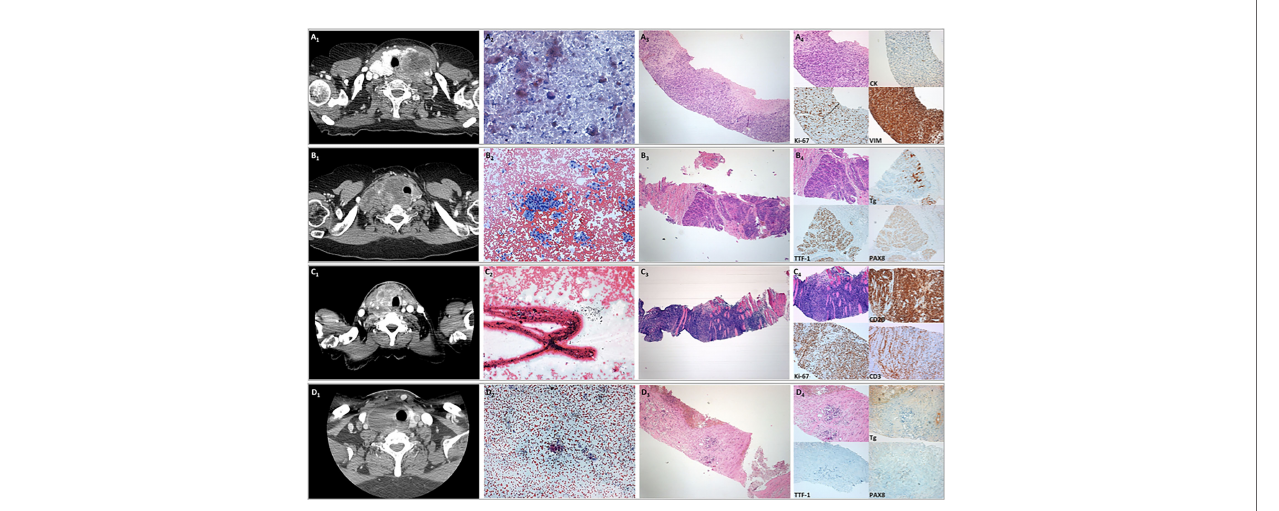
FIGURE 1 | Correlation of the results of CT scan with those of fi ne needle aspiration cytology (FNAC), core needle biopsy (CNB), and speci fi c immunohistochemical staining for anaplastic thyroid carcinoma (ATC), poorly differentiated thyroid cancer (PDTC), thyroid lymphoma (TL), and thyroid gland metastases (TGM) of lung adenocarcinoma. (A) Representative cytological and histological images of a case of ATC. ( A1 ) CT scan with i.v contrast imaging. ( A2 ) FNAC sample showing a few isolated atypical cells in a necrotic background (original magni fi cation, ×40; Papanicolaou staining). ( A3 ) CNB provided a tissue fragment composed of malignant undifferentiated neoplasia (original magni fi cations, ×4 and ×10; H&E staining). ( A4 ) Immunohistochemical staining showing neoplastic cells with a high proliferative index, immunoreactivity for vimentin, and patchy weak immunopositivity for cytokeratins. (B) Representative cytological and histological images of a case of poorly differentiated thyroid carcinoma. ( B1 ) CT scan with i.v contrast imaging. ( B2 ) FNAC sample showing numerous groups of follicular cells with moderate nuclear atypia (original magni fi cation, ×10; Papanicolaou staining). ( B3 ) CNB showing neoplastic cells arranged in solid and trabecular architecture (original magni fi cations, ×4 and ×10; H&E staining). ( B4 ) Immunohistochemical staining showing focal weak immunoreactivity for thyroglobulin and diffuse immunoreactivity for TTF-1 and PAX8. (C) Representative cytological and histological images of a case of TL. ( C1 ) CT scan with i.v. contrast imaging. ( C2 ) FNAC sample not diagnostic for the presence of extensive crush artifacts (original magni fi cation, ×20; Papanicolaou staining). ( C3 ) CNB provided a fragment of tissue composed of muscular tissue with intense lymphoid in fi ltration (original magni fi cations, ×4 and ×10; H&E staining). ( C4 ) Immunohistochemical staining showing that neoplastic cells were CD20 positive and CD3 negative with high proliferative indices compatible with B-cell lymphoma. (D) Representative cytological and histological images of a case of carcinoma of extra-thyroid origin. ( D1 ) CT scan with i.v contrast imaging. ( D2 ) FNAC sample showing a few groups of epithelial cells with marked nuclear atypia (original magni fi cations, ×10 and ×40 in the insert ; Papanicolaou staining). ( D3 ) CNB showing a few clusters of neoplastic cells interspersed in fi brotic stroma (original magni fi cations, ×4 and ×10; H&E staining). ( D4 ) Immunohistochemical staining showing the absence of immunoreactivity for thyroglobulin, TTF-1, and PAX8, suggesting an extra-thyroid